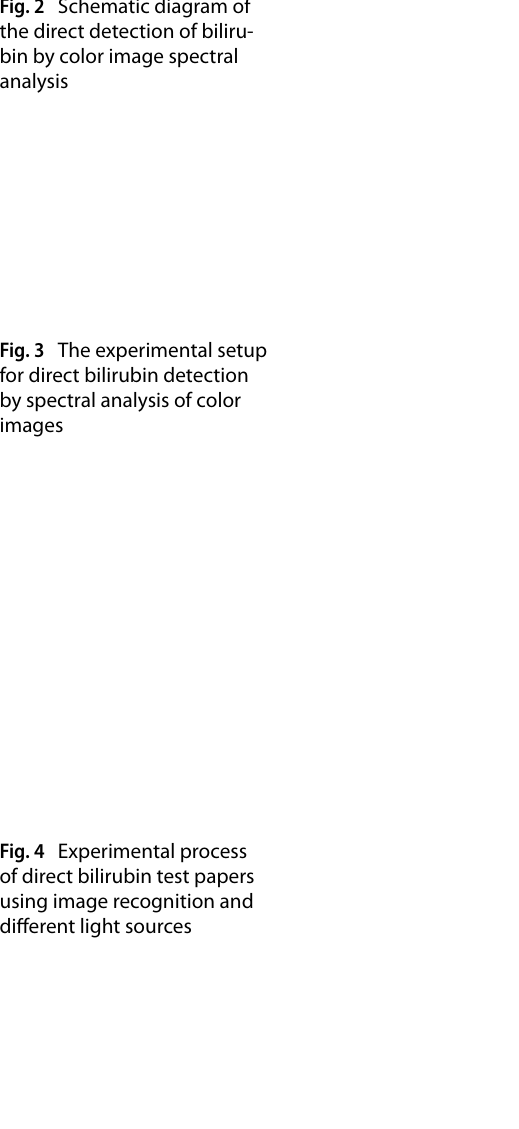
Fig. 2 Schematic diagram of the direct detection of biliru- bin by color image spectral analysis